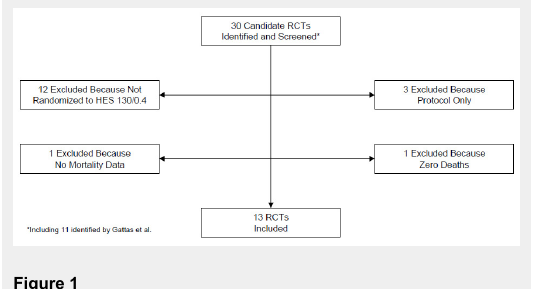
Process of RCT selection for the updated meta-analysis. Abbreviations: HES, hydroxyethyl starch; RCT, randomised controlled trial.